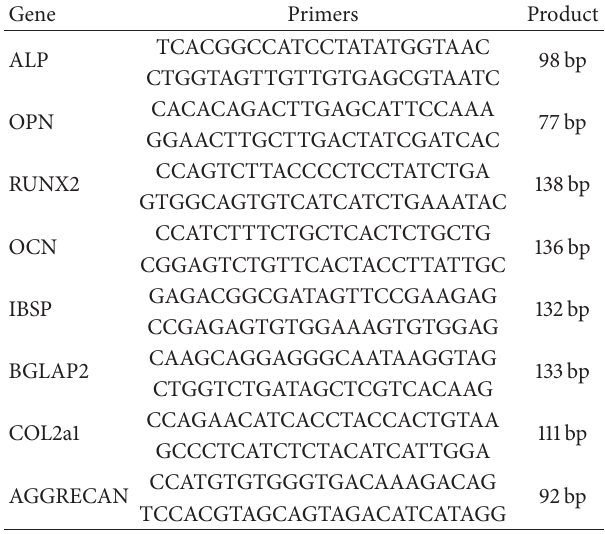
Table 2: The primers sequence for RT-PCR.